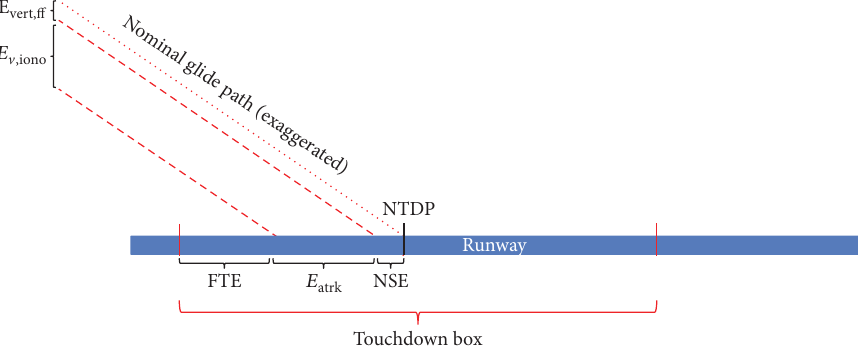
Figure 2: Derivation of the largest allowable vertical error 𝐸 V ,